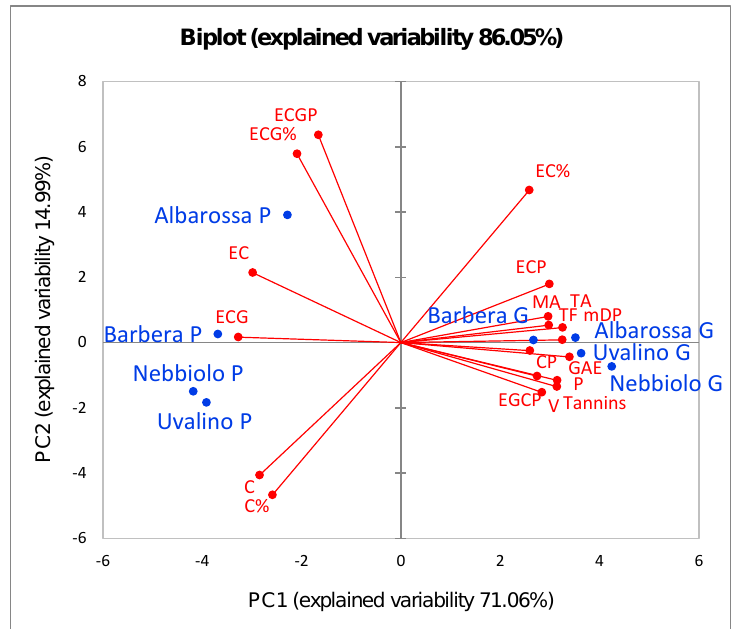
Figure 1. Representation of the loadings (variables) and the scores (skin extracts) in the plane defined by the 1st and 2nd Principal Components (PCA). For each cultivar (blue), the suffix G represents grape extracts, P represents pomace extracts. In red are reported the chemical variables that describe the polyphenolic profile of the extracts: GAE = total polyphenols; TF = total flavonoids; TA = total anthocyanins; MA = monomer anthocyanins; V = flavans reactive with vanillin; P = proanthocyanidins; Tannins = condensed tannins (phloroglucinolysis); mDP = mean degree of polymerization; C, EC, ECG = (+)-catechin, (−)-epicatechin and (−)-epicatechin-3- O -gallate present as terminal units; CP, ECP, ECGP = (+)-catechin, (−)-epicatechin and (−)-epicatechin-3- O -gallate present as extension units; EGCP = (−)-epigallocatechin present only as extension unit; C%, EC%, ECG% = total percentages of the monomers (terminal + extension).